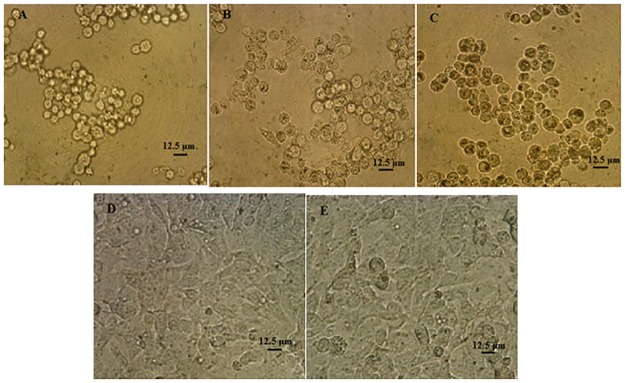
Morphology of the A-431 human epidermoid carcinoma cell lines after 24h incubation with alpha-mannosidase, beta-mannosidase and trypsin enzymes.A. alpha-mannosidase (0.02 unit/ml). B. beta-mannosidase (0.02 unit/ml). C. citrate buffer)100mM, pH 4.5). D. trypsin (0.75 μg/ml). E. Control positive (cells with no enzyme treatment). The experiment was performed 2 times in duplicates.